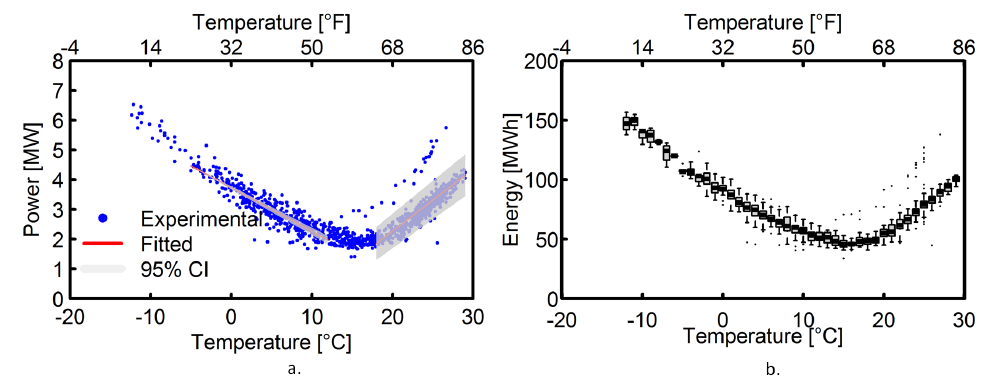
Figure 3. Daily V-curves for power ( a ) and energy ( b ) with linear regression, confidence interval, and box plot example representations for the studied